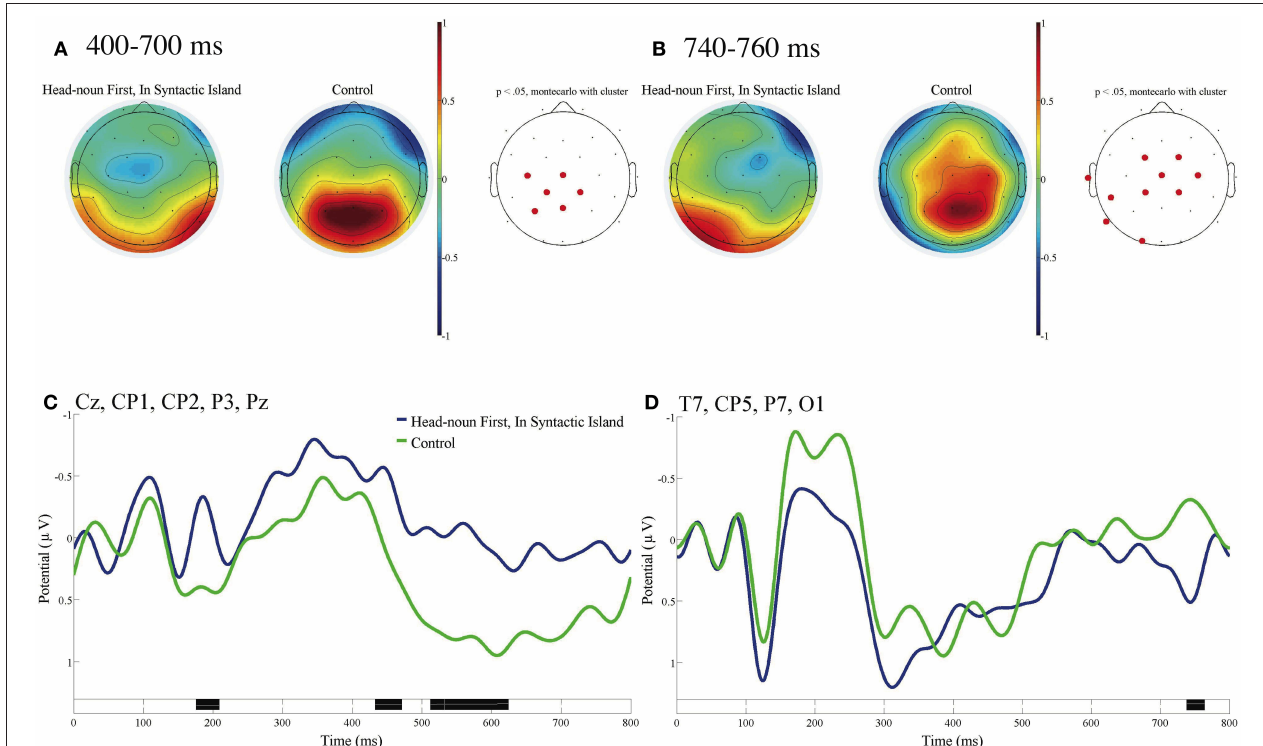
FIGURE 6 | ERPs time-locked to the onsets of the subordinate verbs of In Syntactic Island of Head-noun First and the control in (A–D) with the baseline as 0 to 100 ms. (A) Mean topographies of the ERPs from 400 to 700 ms and (B) those from 740 to 760 ms for the In Syntactic Island (left) and control (right) conditions; the electrode sites at which significant differences were found by using the cluster-based permutation test ( p < 0.05) are depicted in red. (C) Mean ERPs of the two conditions at the (left) centro-parietal electrodes (Cz, CP1, CP2, P3, and Pz) and (D) those at the left temporal-occipital electrodes (T7, CP5, P7, and O1). Negativity is plotted upward, and the time windows during which significant differences were found by the cluster-based permutation test are indicated in black on the time axes in (C,D)